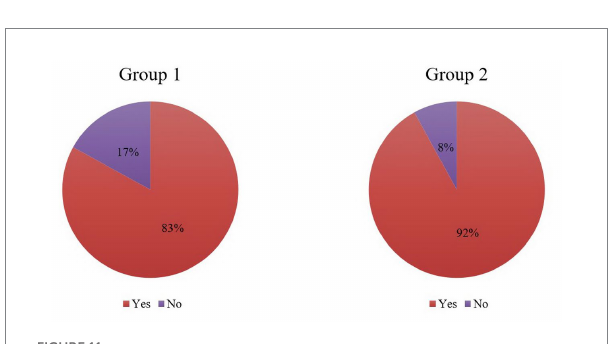
FIGURE 11 Answers to the question: do mobile applications and online educational courses affect the processes of learning, memory development and knowledge sharing? (Post-training survey). Source: compiled by the authors.